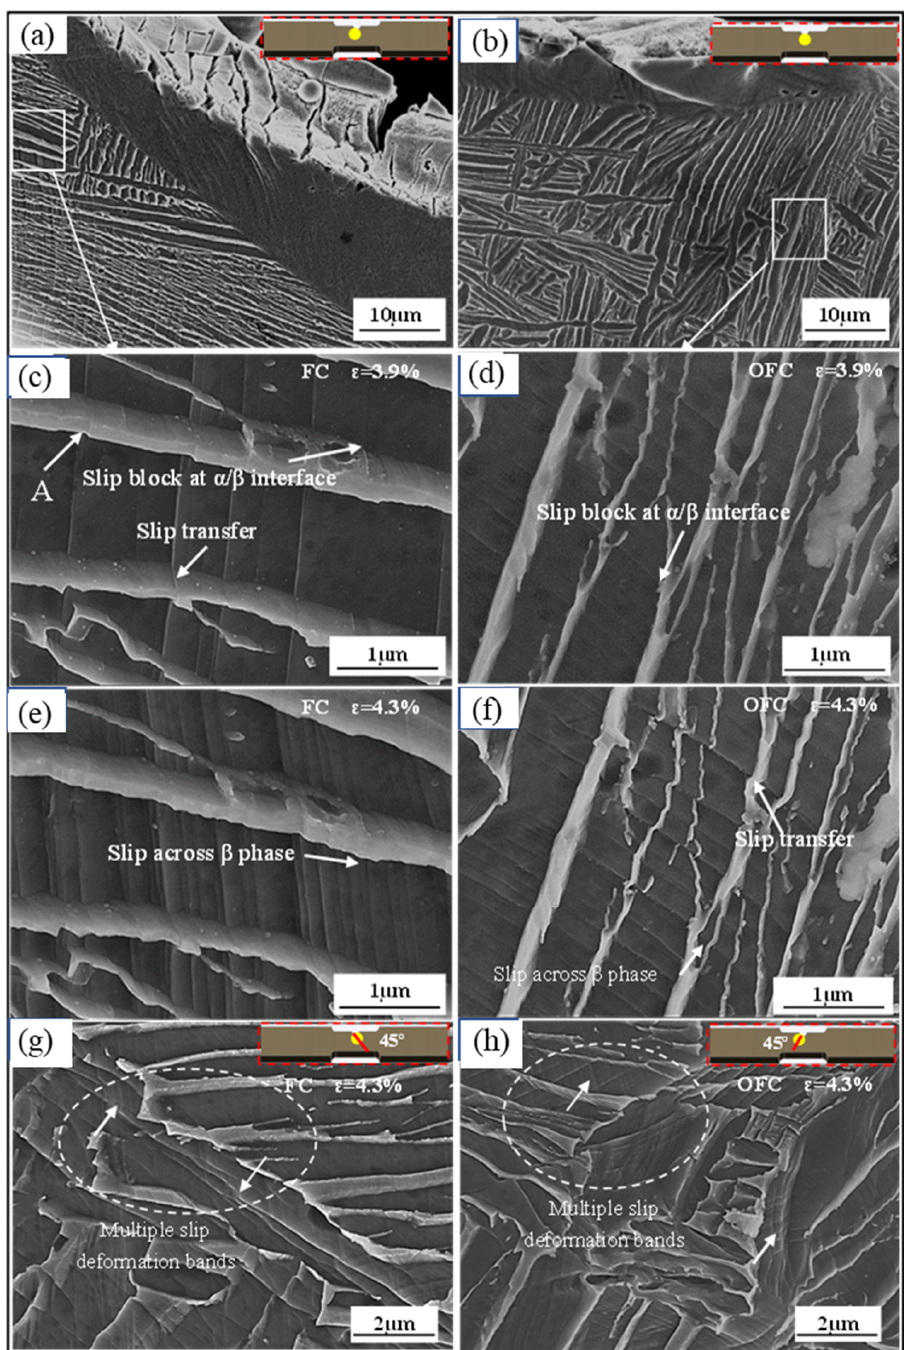
Figure 5. Slip morphologies at ε = 0%, ε = 3.9%, and ε = 4.3% of FC ( a , c , e , g ) and OFC ( b , d , f , h ). The insets show locations on the tensile specimens.